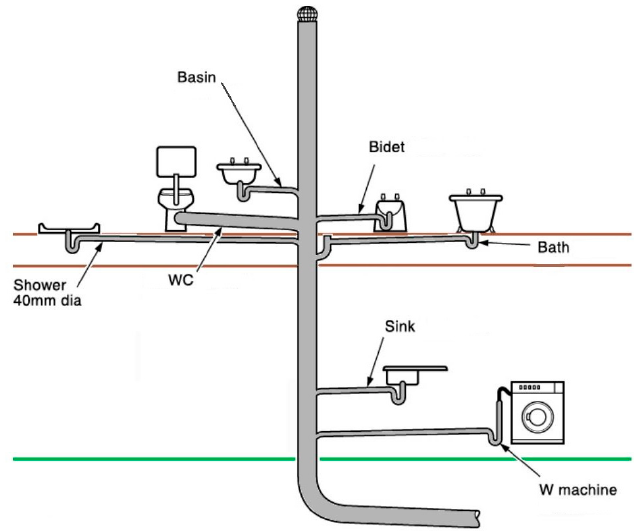
Figure 3. Plumbing system of a conventional household with a vertical stack pipe, P-traps with each appliance and sloped pipes towards the stack [21]. appliance and sloped pipes towards the stack